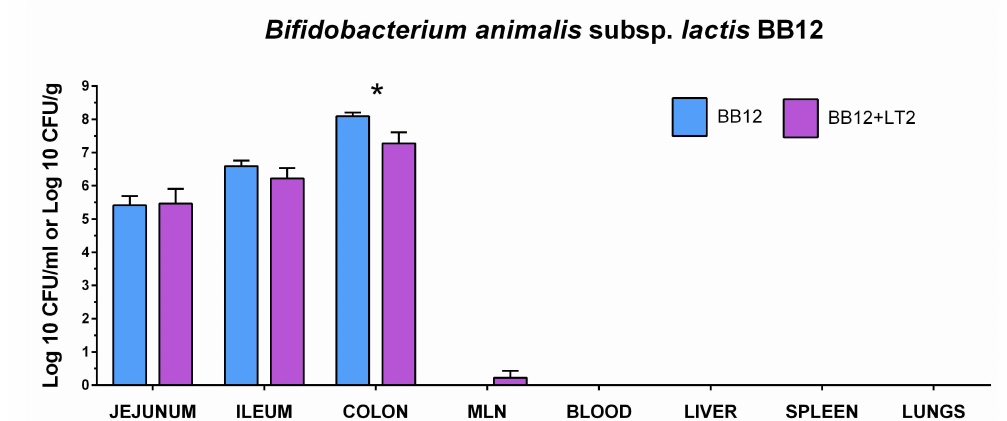
Figure 2. Colony-forming units (CFU) of B. animalis subsp. lactis BB-12 (BB12) in the gnotobiotic piglets. BB12 CFU was counted in the jejunum, ileum, colon, and blood (all CFU/mL) and mesenteric lymph nodes (MLN), liver, spleen, and lungs (all CFU/g) in the piglets monoassociated with BB12 (BB12; blue column) and the piglets monoassociated with BB12 and one week later infected with S . Typhimurium LT2 for 24 h (BB12 + LT2; violet column). Interferences between BB12 and LT2 were evaluated by unpaired t -test, and statistical differences were marked with asterisks at p < 0.05. Log CFU are depicted as mean + SEM and n = 6 piglets for all groups.